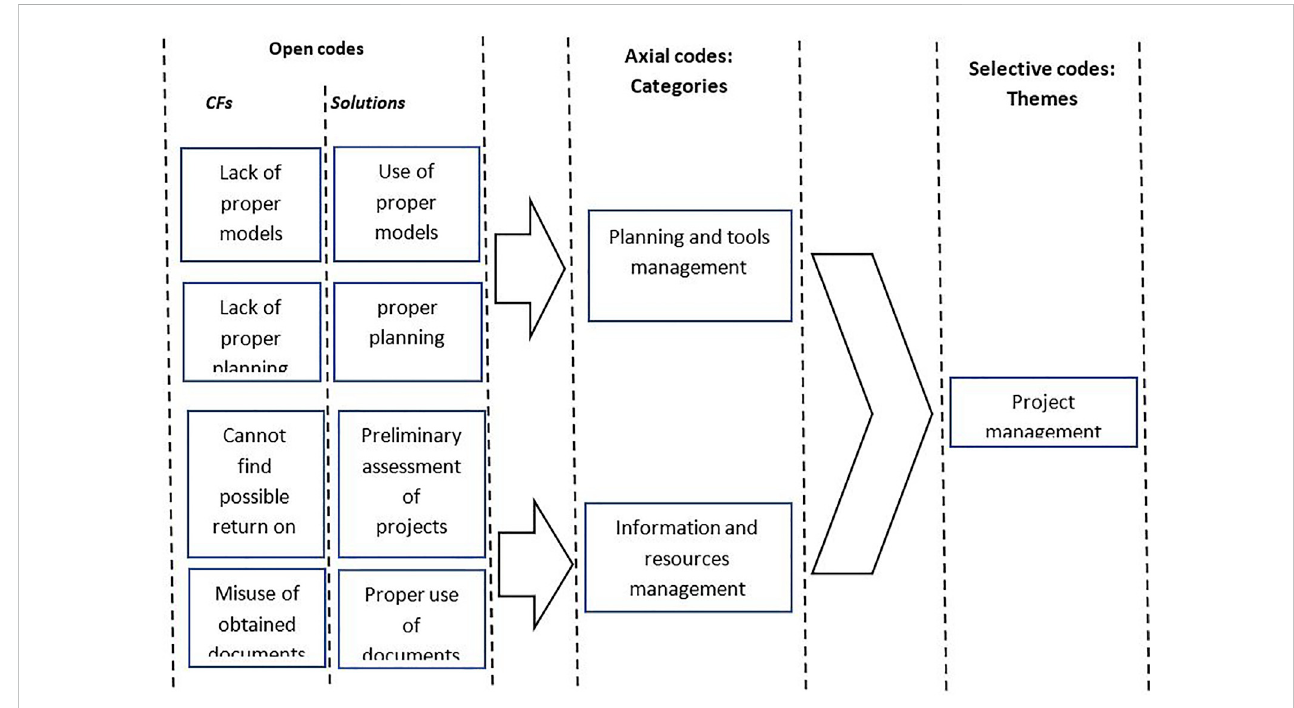
FIGURE 1 Extract of the coding process from open codes to selective themes.